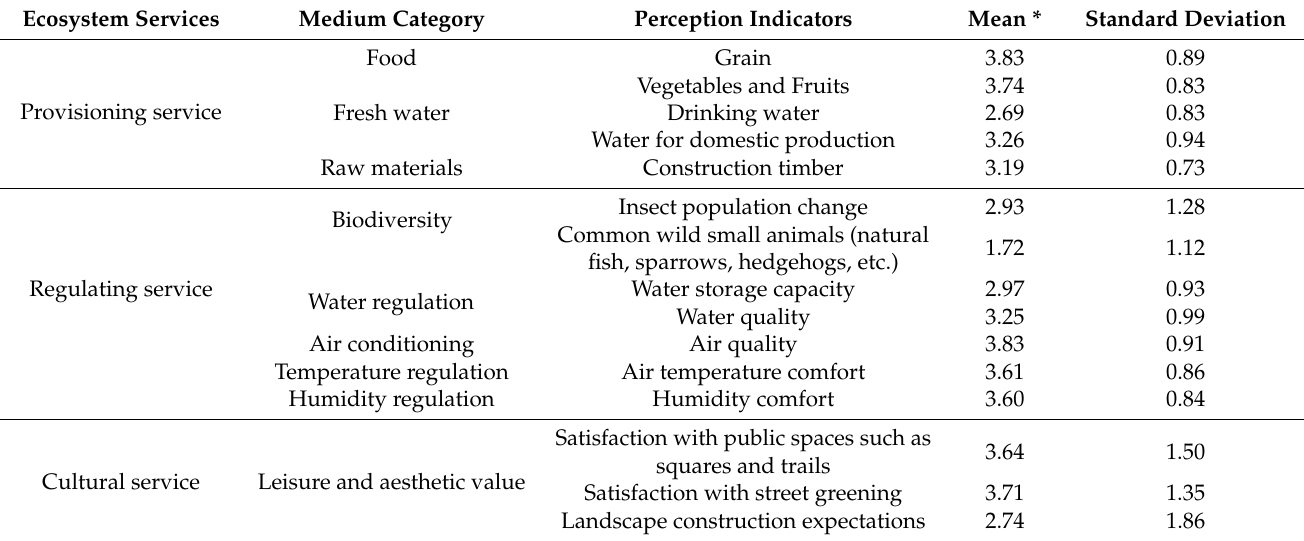
Table 3. Perception measures of rural residents on ecosystem